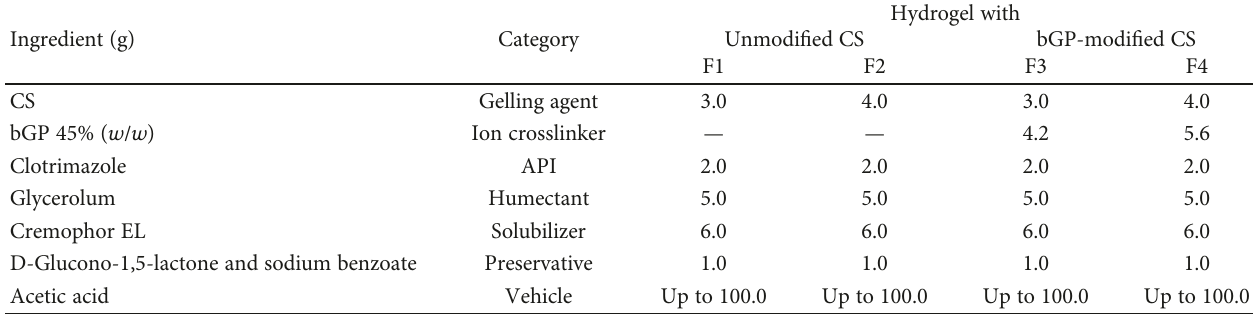
Table 1: Composition of hydrogels with unmodi fi ed CS (F1, F2) or bGP-crosslinked CS (F3, F4).